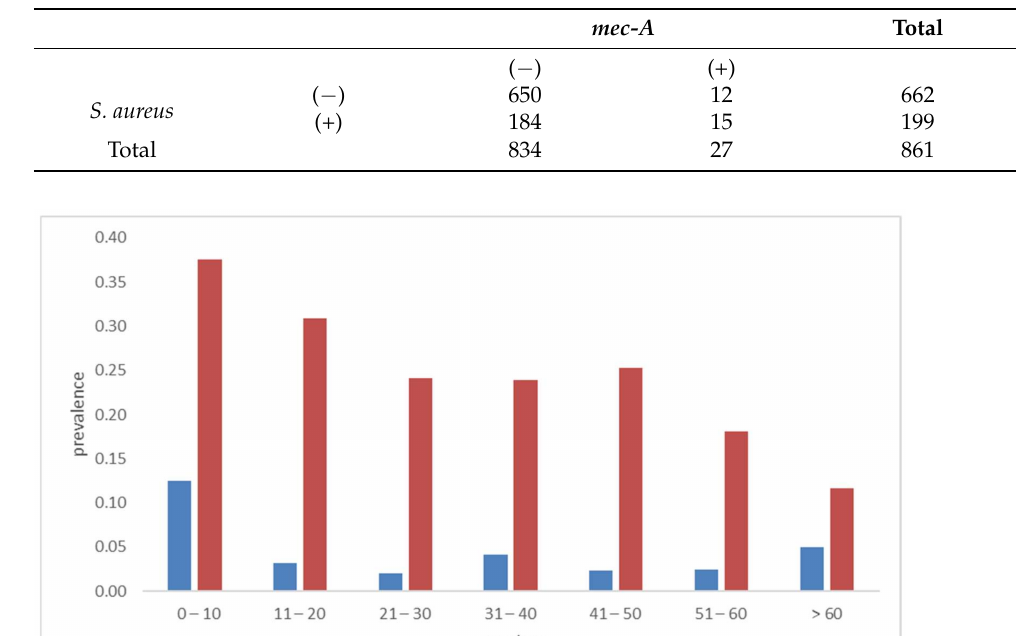
Table 2. Contingency table showing the occurrence of S. aureus and mec-A gene.